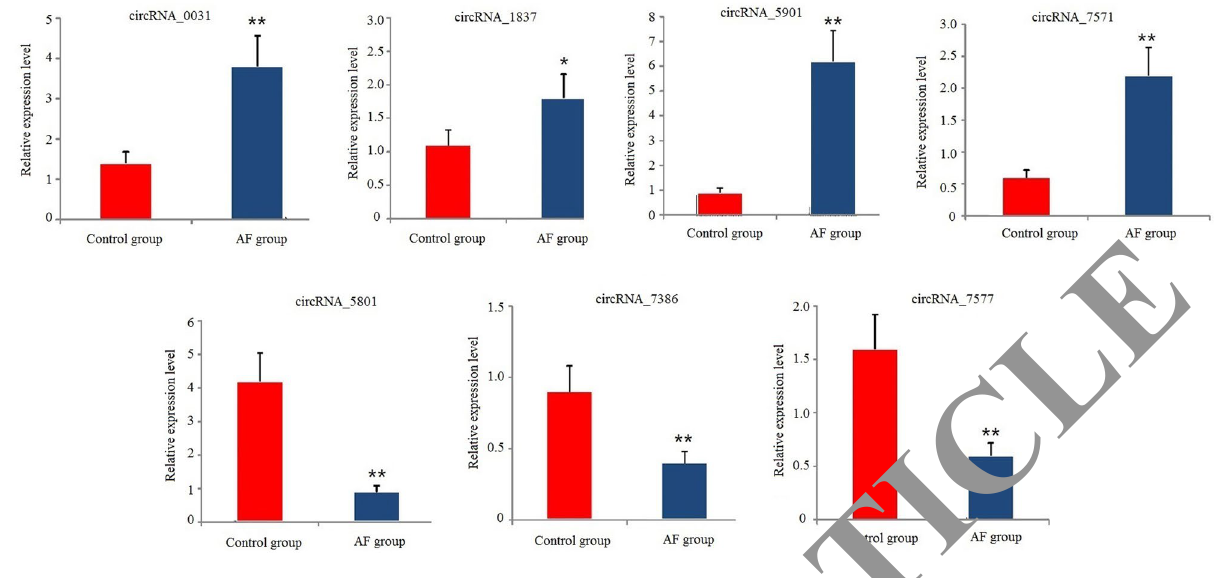
Figure 2. Quantitative reverse transcription polymerase chain reaction analysis for validation of differentially expressed circRNAs. Compared with control group, *P < 0.05 and **P < 0.01.